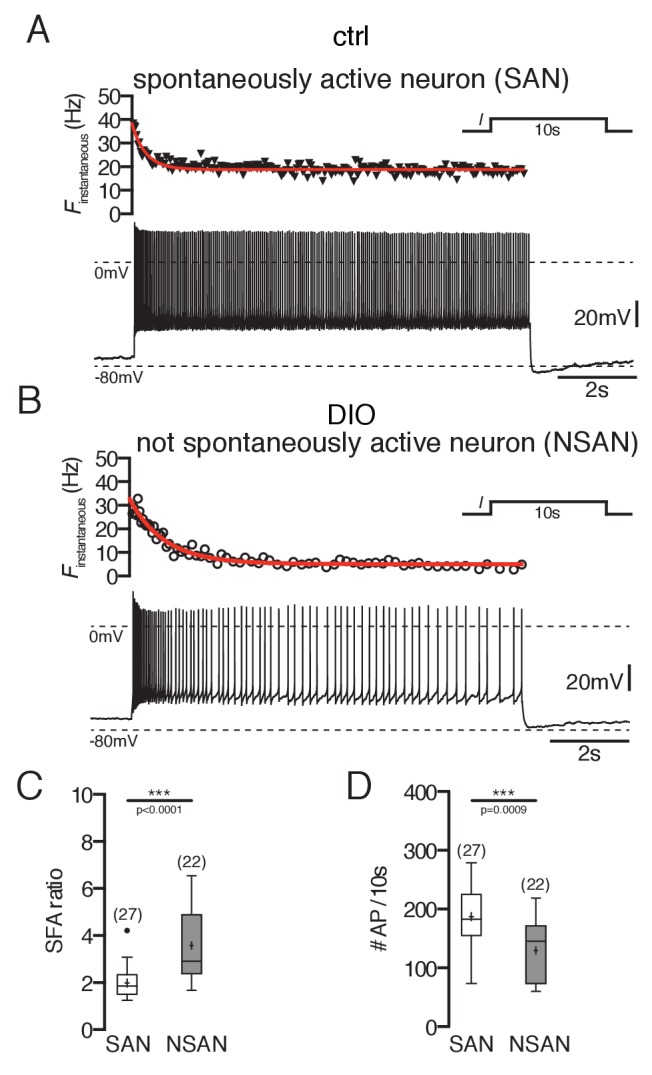
Spike frequency adaptation of POMC neurons is stronger in DIO mice.(A and B) Original recording (bottom) and the corresponding instantaneous spike frequency plot (top) of a spontaneously firing (A) and silent (B) POMC neuron during a 10 s depolarizing current injection. (C and D) SFA ratios are higher in silent POMC neurons (C) and, accordingly, the number of APs during the 10 s depolarization decreased (D) (Mann-Whitney test). SFA, spike frequency adaptation; SAN, spontaneously active neuron; NSAN, not spontaneously active neuron (F < 0.5 Hz). ***p<0.001.